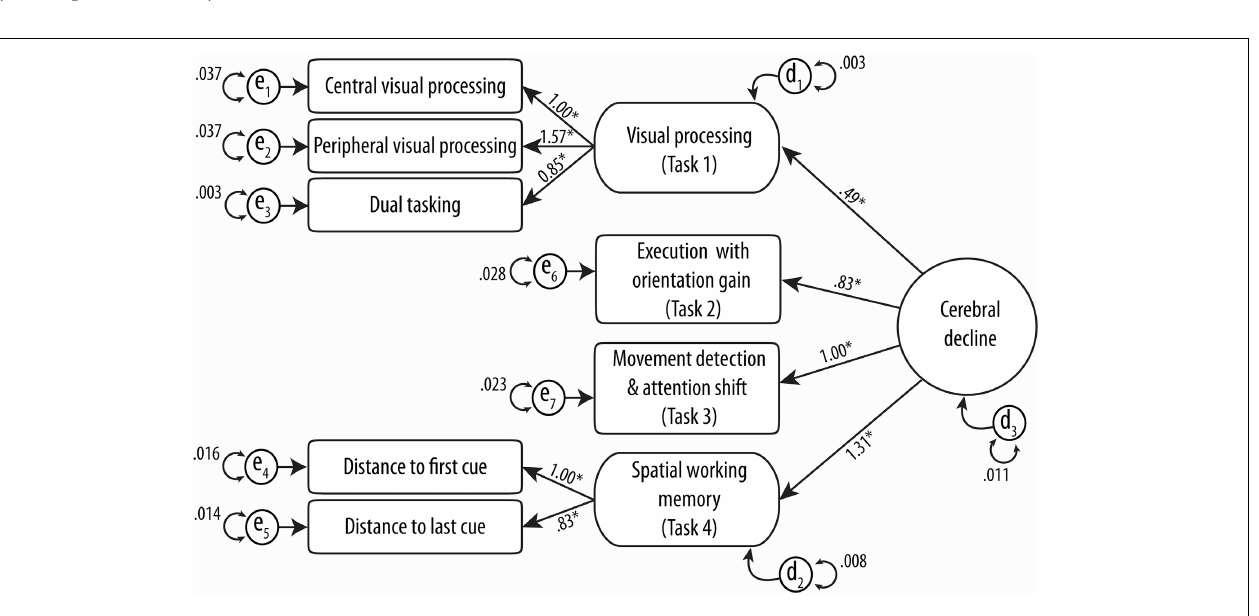
model “cerebral decline.” e n models residual errors for observed variables and d n models the same errors for latent variables. ∗ Identifies variables that contribute significantly (LRtest p -value < 0.05) to the